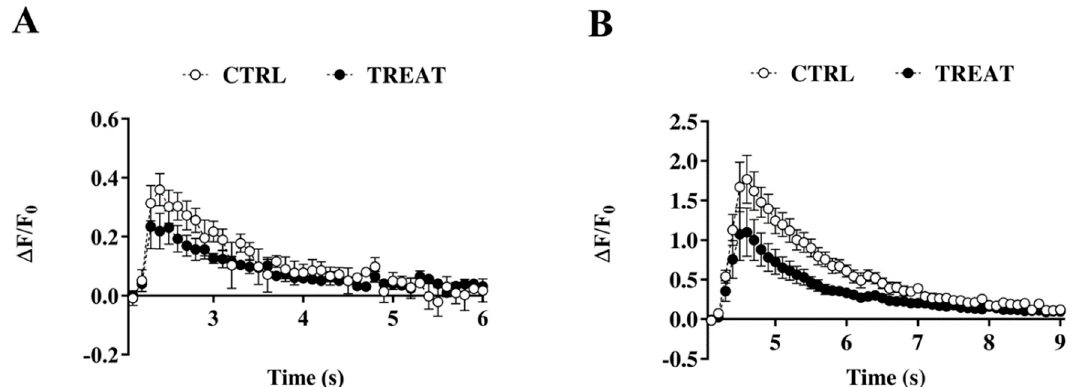
Figure 5. Intracellular somatic calcium transients. ( A ) Calcium transients evoked by single action potentials; ( B ) calcium transients evoked by 300 ms-20 Hz action potentials burst. Creatine maternal supplementation significantly decreases calcium influx during 20 Hz action potential burst in CA1 neurons. Two-way ANOVA with Time and Treatment (CTRL vs. TREAT) as independent variables while the litter was considered as a blocking factor; Time : F (1, 645) = 305.47 p < 0.001, Treatment : F (1, 645) = 51.74 p < 0.001, Time-by-Treatment Interaction : F (1, 645) = 19.02 p < 0.001. Sidak’s multiple comparisons test: p < 0.05 from 4.9 to 5.6 s. CTRL = 8 neurons from 5 rats; TREAT = 5 neurons from 4 rats.